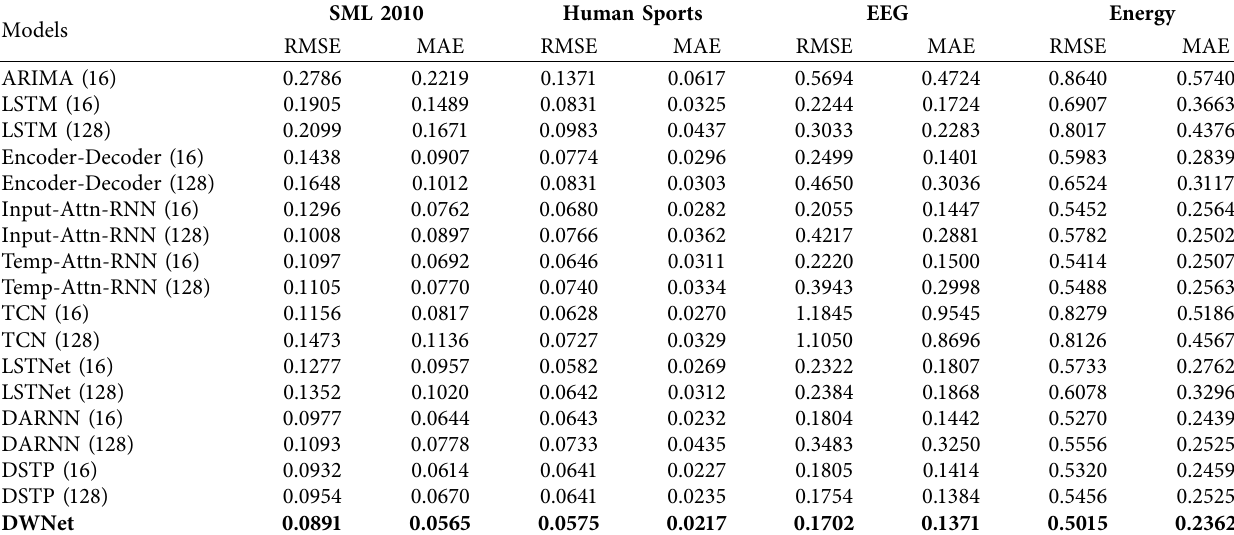
Table 1: RMSE and MAE performance comparison among different methods and datasets (best result is displayed in boldface ). Models